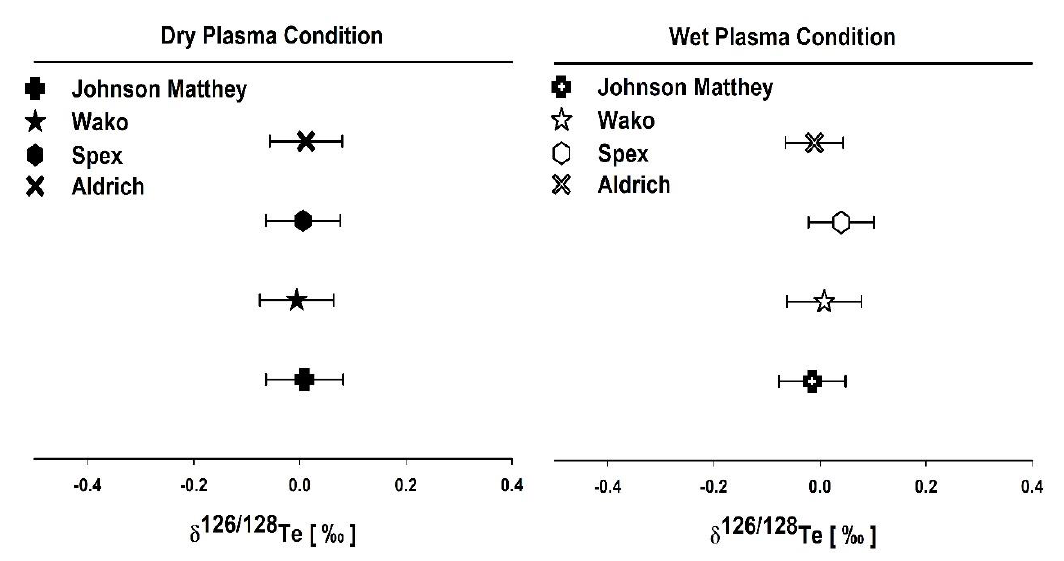
Figure 5. The dry and wet plasma measurements of δ 126/128 Te for four terrestrial Te standards plotted with respect to the Kanto standard (Kanto Chemical). The error bars are expressed in 2SD.